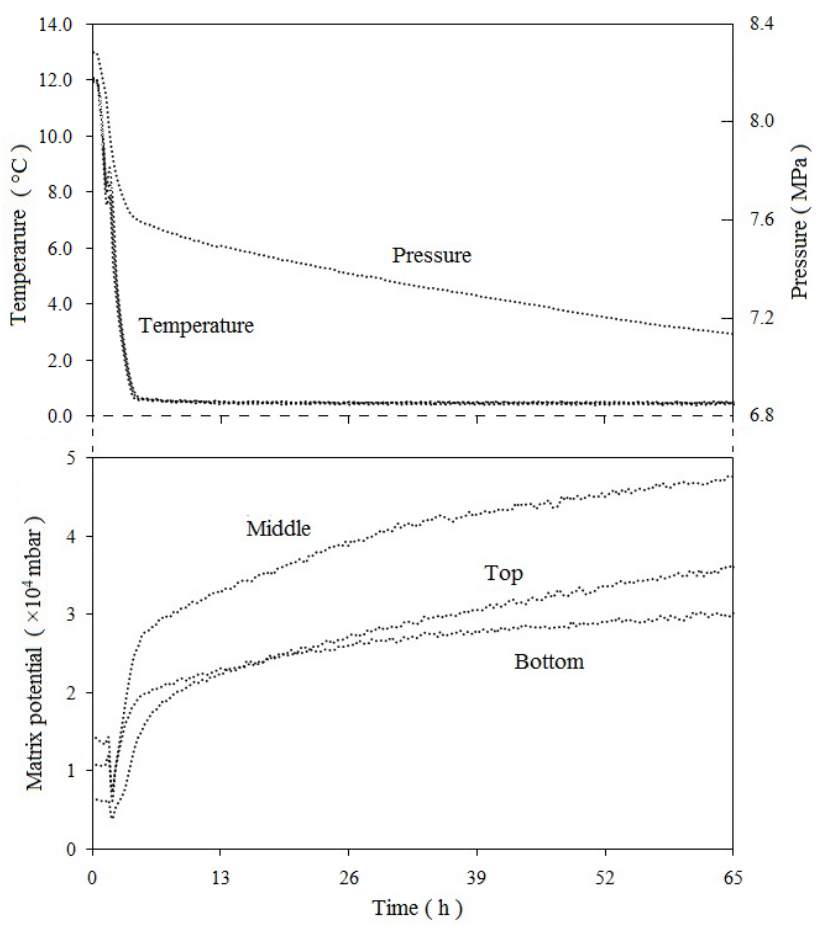
Figure 8. Temperature, pressure, and matrix potential changes as functions of reaction time in